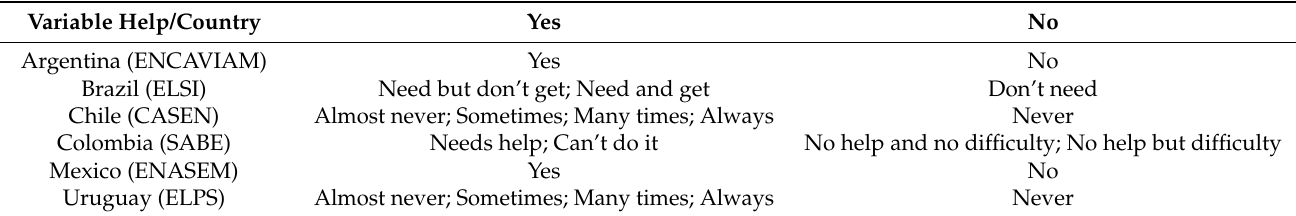
Table 4. Reclassification of original variables into a new variable (‘help’) +